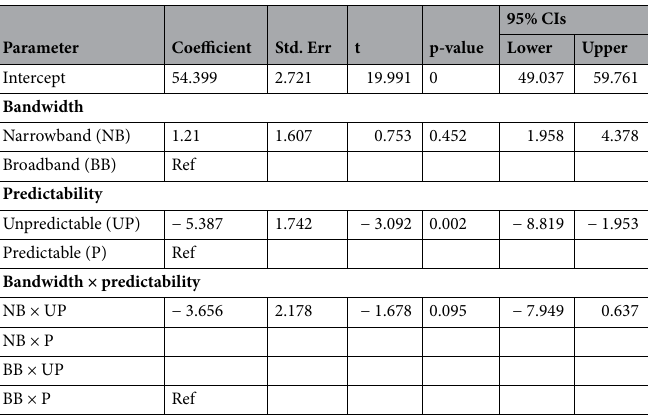
Table 4. Fixed coefficients of the Generalized Linear Mixed Model (GLMM), including: estimate strength (Estimates), standard errors (Std. Errs), t-statistics (t), probability value (p-value) and 95% confidence intervals (Cis), for each fixed effect and the interaction bandwidth ×